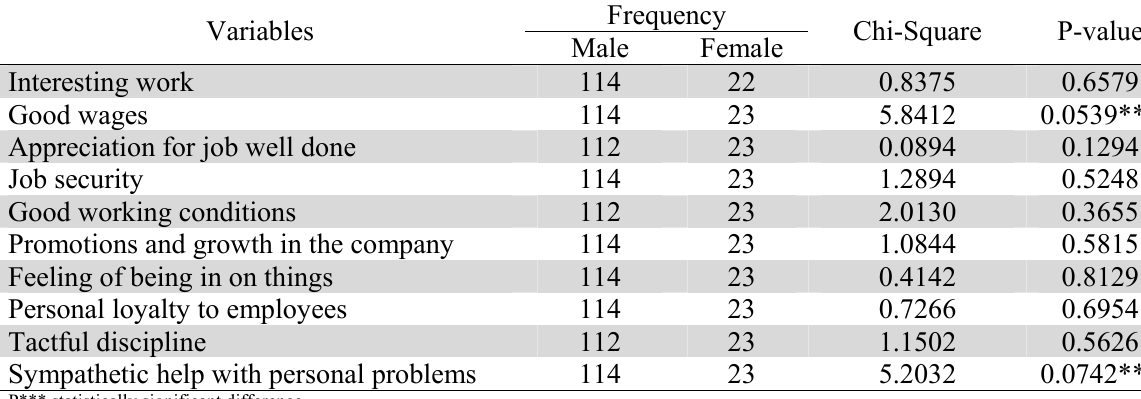
Chi square test for Gender as independent variable